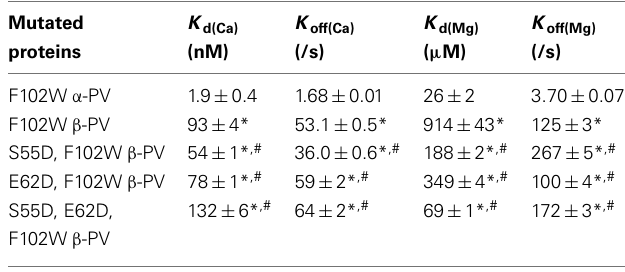
Table 1 | Summary of the Ca 2 + and Mg 2 + binding properties of the modified PVs.